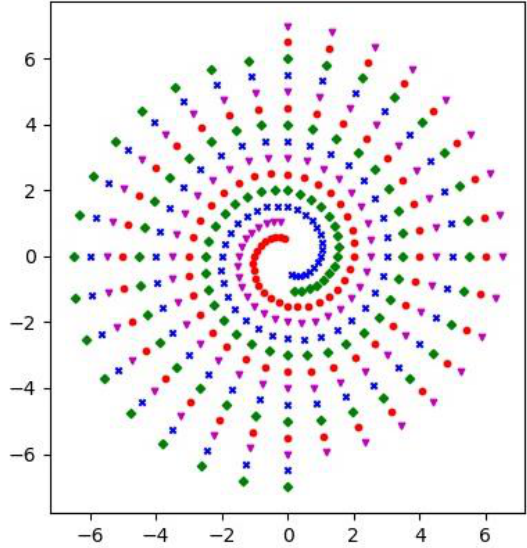
Figure 7. Four spirals classification problem.